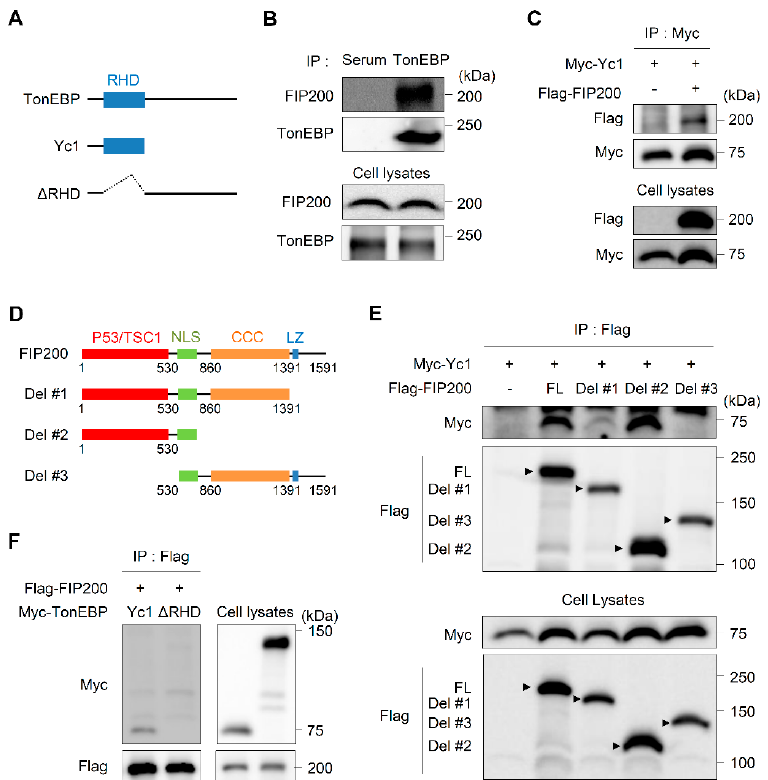
Figure 3. TonEBP interacts with FIP200 through the Rel-homology domain. ( A ) Domain structures of human TonEBP and deletion constructs Yc1 and ∆ Rel-homology domain (RHD). ( B ) MIN6-M9 cell lysates were immunoprecipitated (IP) with TonEBP antibody or normal serum as indicated. Cell lysates and precipitated proteins were immunoblotted for FIP200 and TonEBP. ( C ) Cells were transfected with plasmids expressing Myc–Yc1 without or with Flag–FIP200 as indicated. Cell lysates were immunoprecipitated with an anti-Myc antibody. Cell lysates and precipitated proteins were immunoblotted for Myc and Flag. ( D ) Domain structures of human FIP200 and deletion constructs Del #1, #2 and #3. ( E ) HEK293 cells were transfected with plasmids expressing Myc-Yc1 together with Flag-tagged FIP200 (FL), Del #1, Del #2 or Del #3 as indicated. Cell lysates were immunoprecipitated with an anti-Flag antibody. Cell lysates and precipitated proteins were immunoblotted for Myc and Flag. ( F ) HEK293 cells were transfected with a plasmid expressing Flag–FIP200 together with a plasmid expressing Myc–Yc1 or Myc– ∆ RHD as